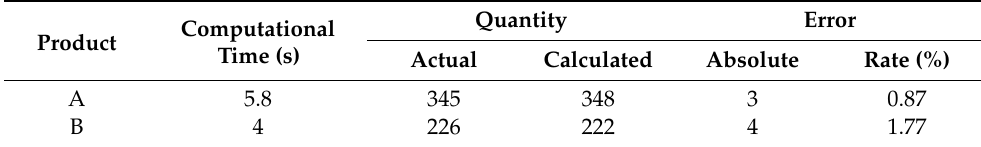
Table 4. Analysis of the computational time and